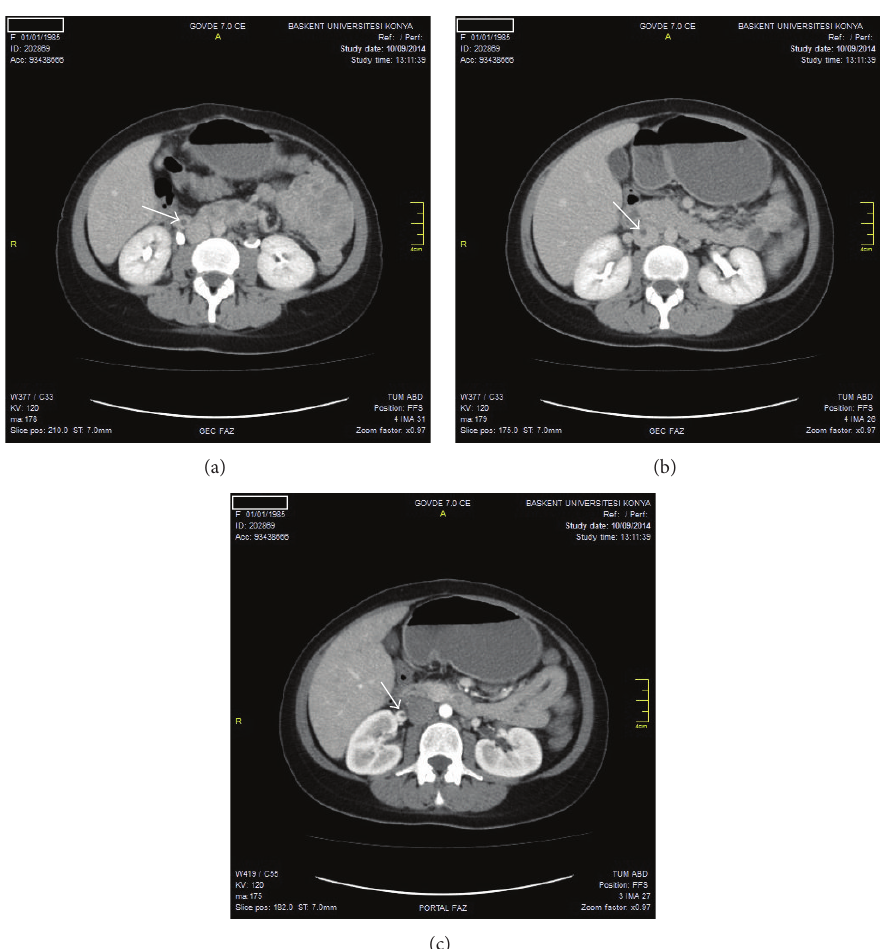
Figure 1: (a) Ovarian vein thromboses. On axial CT image, hypodense thrombus seen in right ovarian vein. (b) Inferior vena cava vein thromboses. On axial CT image, hypodense thrombus seen in vena cava inferior. (c) Renal vein thrombosis. On axial CT image, hypodense thrombus seen in right renal